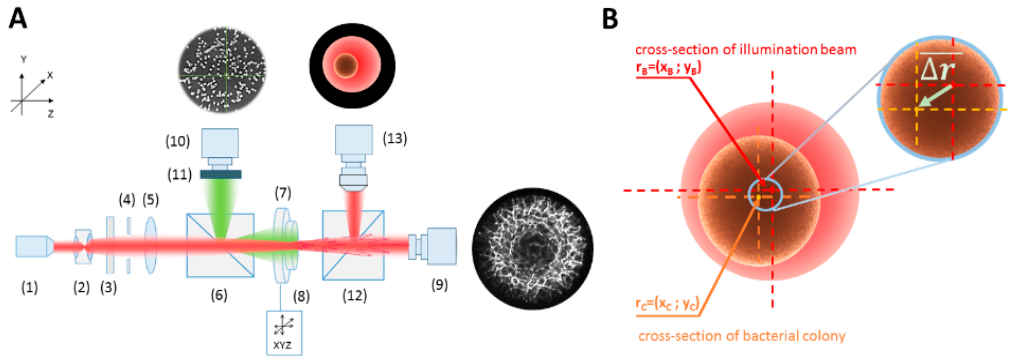
Figure 1. ( A ) The schematics of the miniaturized optical system for recording the di ff raction patterns, where: (1) the laser diode module (635 nm, 1 mW, collimated, CPS635R, Thorlabs), (2) beam expander BE (1.5X, BE052-A, Thorlabs), (3) amplitude filters wheel (OD: 0–2, NDC-50C-2M-A, Thorlabs), (4) iris-diaphragm (diameter: 0–2.5 cm, ID25, Thorlabs), with automatically controlled diameter, (5) transforming lens L (f = 20 cm, AC254-200-A-ML, Thorlabs), (6) beam splitter (CM1-BP150, Thorlabs), (7) sample of bacterial colonies in the Petri dish on (8) automatic X–Y translation stage (travel range 150 mm, minimum incremental movement: 0.1 µ m, NRT150 / M, Thorlabs), (9) di ff raction patterns recording CCD camera (EO-1312) with imaging objective (f = 3.5 cm, 59–872, Edmund Optics) and a computer unit (8). ( B ) The exemplary description of the analyzed ∆ r-parameter of misalignment.